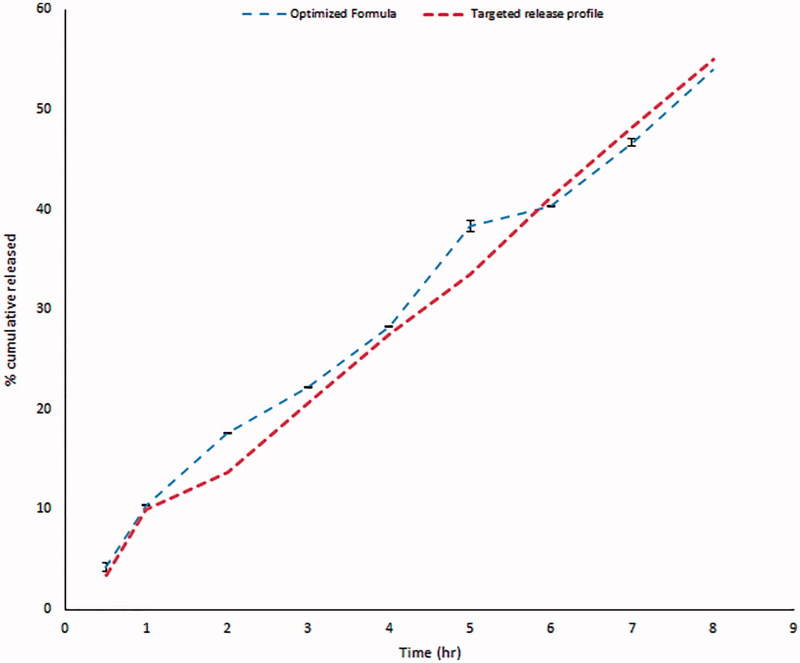
In vitro release profile of GBP from the optimized formula in 0.1 N HCl.